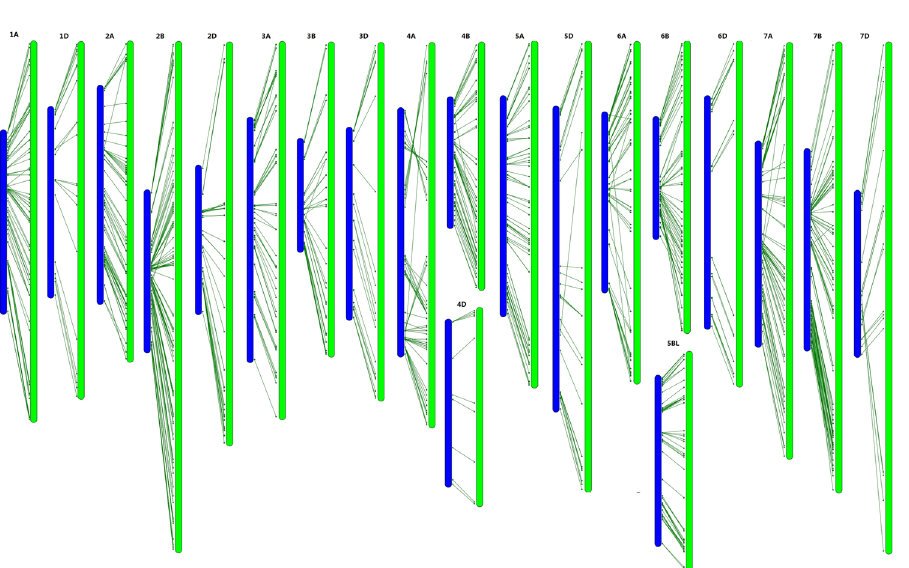
Figure 6. Synteny of the mapped SNPs from the Wheat660K SNP array (in blue ) with that from the Wheat820K array (in green ) based on their common CSS-assembled contigs. Notes: The genetic maps of chromosomes 3A, 4B, 5D, 6D and 7B derived from the Wheat820K SNP array are shown in inverted form, with long arms at the top and short arms at the bottom 18 . In this figure, these inversions were